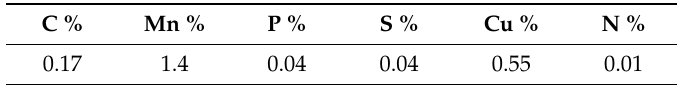
Table 1. Chemical composition of S235JR steel [18].